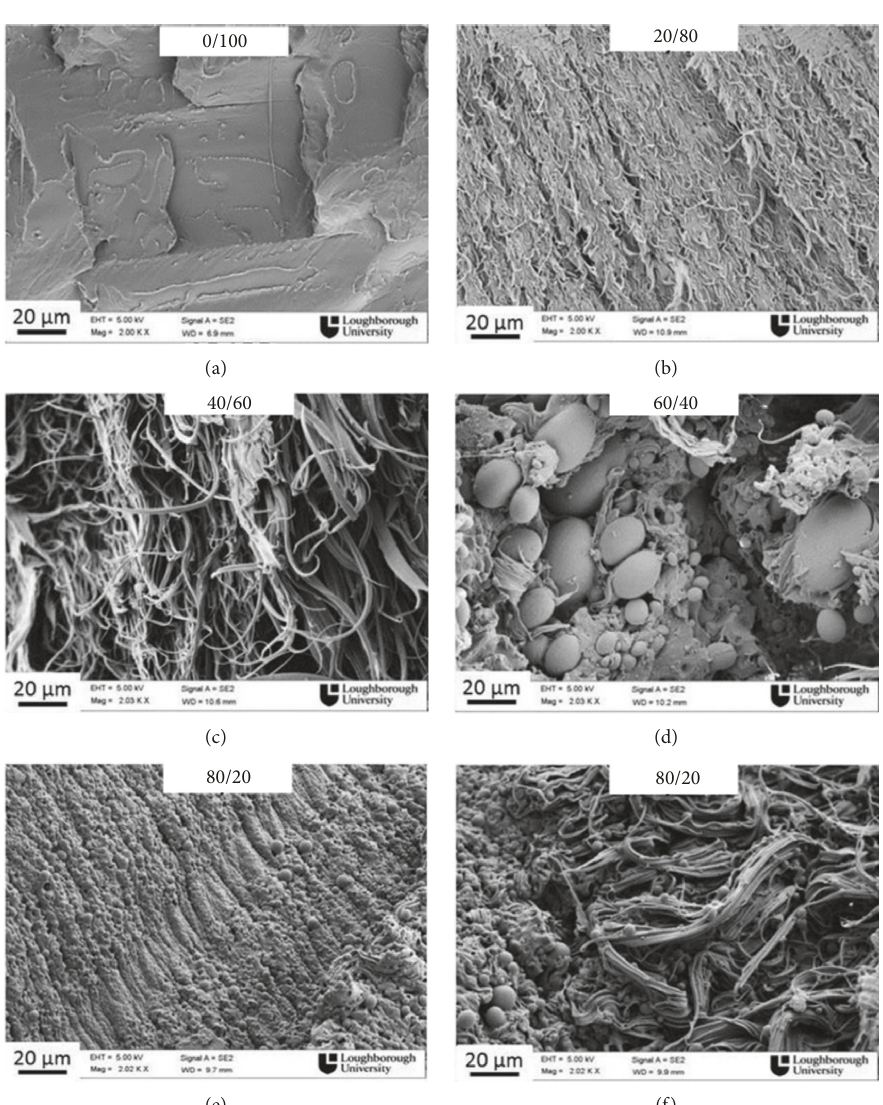
Figure 5: SEM micrographs of fracture surfaces from the tensile tests of PBAT/PLA blends (adapted with permission from ref. [30]).